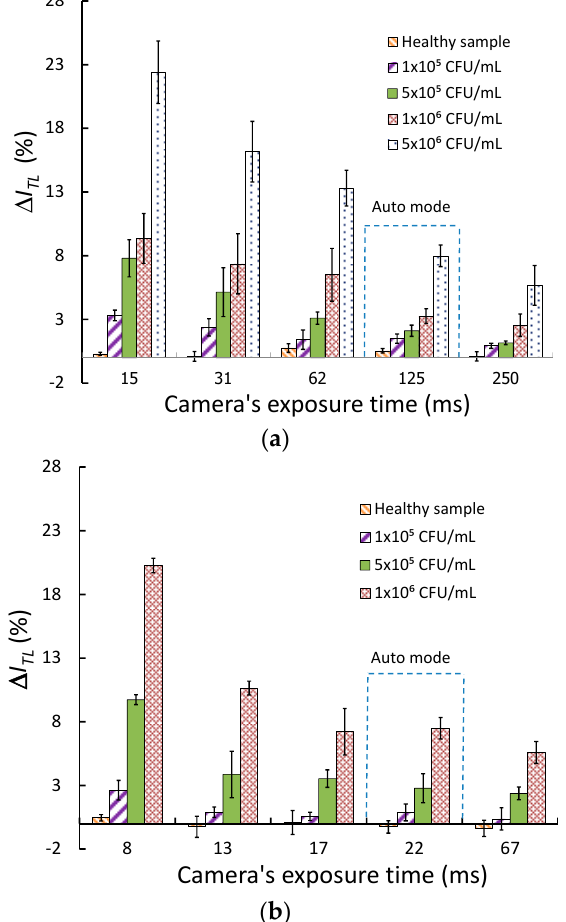
Figure 3. Relative intensity drops ∆ I TL at the strip’s test line for various Aac bacteria concentrations plotted as a function of camera exposure time for ( a ) the web-camera reader, N = 5 for each concentration, and ( b ) the iPhone reader, N = 3 for each concentration.